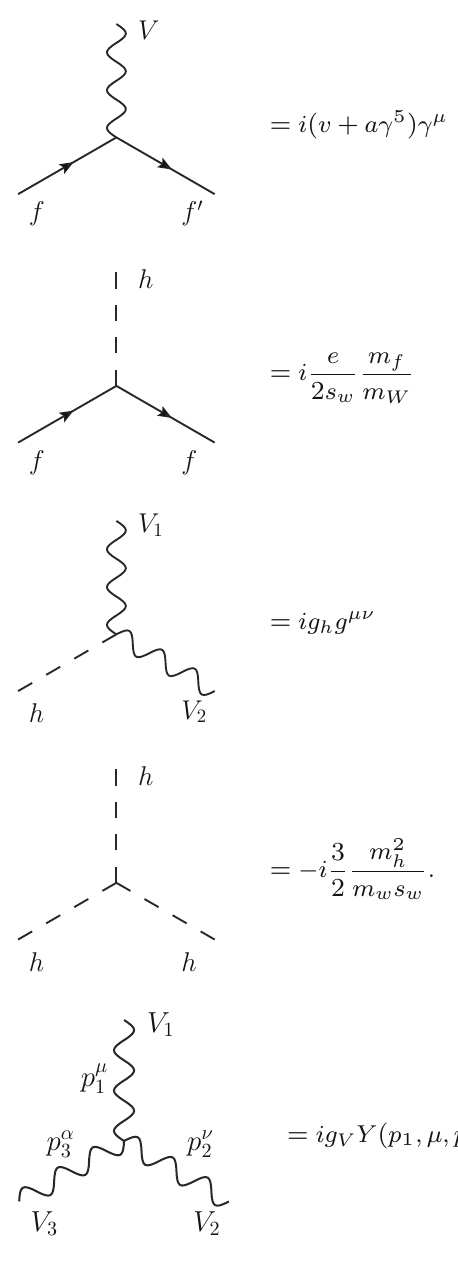
Fig. 8 The vertex interactions of the electroweak